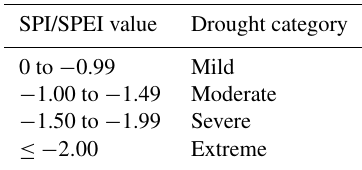
Table 3. Drought classification using SPI/SPEI according to McKee et al.